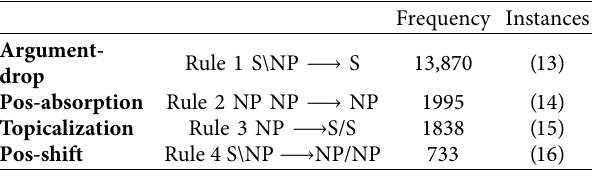
Table 4: NCR of highest frequency under each subtype.